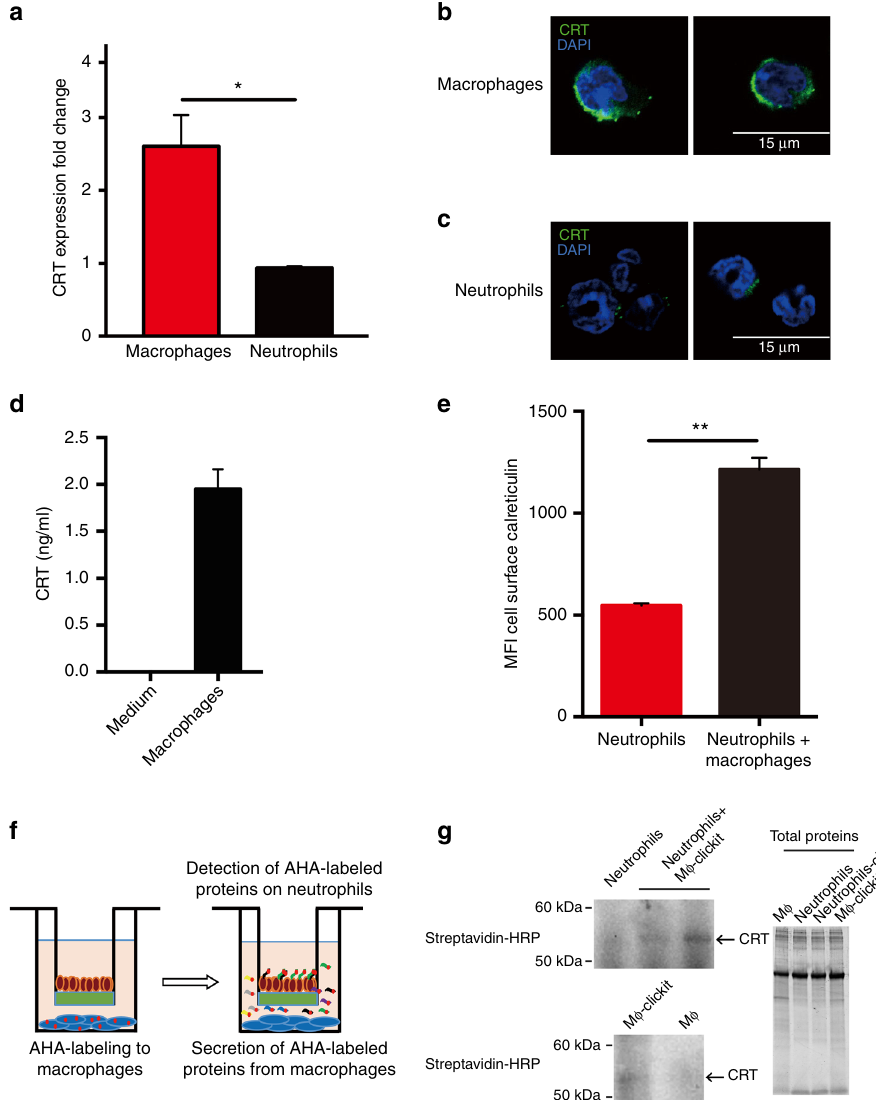
Fig. 3 Macrophages are the sources of CRT and secrete CRT to label the target cells. a Expression of CRT measured by qRT-PCR in neutrophils and macrophages 8 h after thioglycollate. Macrophages and neutrophils were collected from MRP8-Bcl2 mice as described in “ Experimental Procedures ” . CRT mRNA level in macrophages were dramatically higher in macrophages as compared to neutrophils. * P < 0.05 ( t -test) for expression of CRT between macrophages and neutrophils. Error bars represent standard deviation. b , c Immuno fl uorescent staining of CRT in mouse macrophages ( b ) and neutrophils ( c ). CRT is undetectable in neutrophils but abundant in macrophages. CRT localized to perinuclear regions, vesicles and cell surface of macrophages. Macrophages and neutrophils were collected from MRP8-Bcl2 mice. d ELISA assay showing the amount of CRT in medium (RPMI) with and without macrophages. n = 3. Error bars represent standard deviation. Macrophages were able to secrete CRT to the extracellular medium. e Expression levels of cell surface CRT on neutrophils cultured alone or with macrophages in a 0.4- μ m Boyden chamber overnight, assayed by fl ow cytometry. Co-culture with macrophages led to a signi fi cant increase of cell surface CRT on neutrophils. n = 3. ** P < 0.01 ( t -test) for expression levels of cell surface CRT on neutrophils cultured alone or with macrophages. Error bars represent standard deviation. f A schematic showing the Click-iT assay to examine transfer of CRT from macrophages to neutrophils during co-culture. Macrophages proteins were labeled with a methionine analog AHA ( L -azidohomoalanine) receptive for click chemistry. The proteins secreted by macrophages were all labeled with AHA. Because neutrophils and macrophages were cultured in a way independent of contact, the AHA-labeled proteins detected on neutrophils originate from the macrophages. g Neutrophils were cultured alone or together with AHA-treated macrophages in a 0.4- μ m Boyden chamber. Cells were collected and CRT was immunoprecipitated and then subjected to click- chemistry adding in biotin to receptive methionine analogs. Samples were subjected to SDS-PAGE and then western blot for the presence of biotin. Detection of AHA-labeled CRT on neutrophils indicated that macrophage-secreted CRT to label neutrophils and this was independent of the contact between these two cell